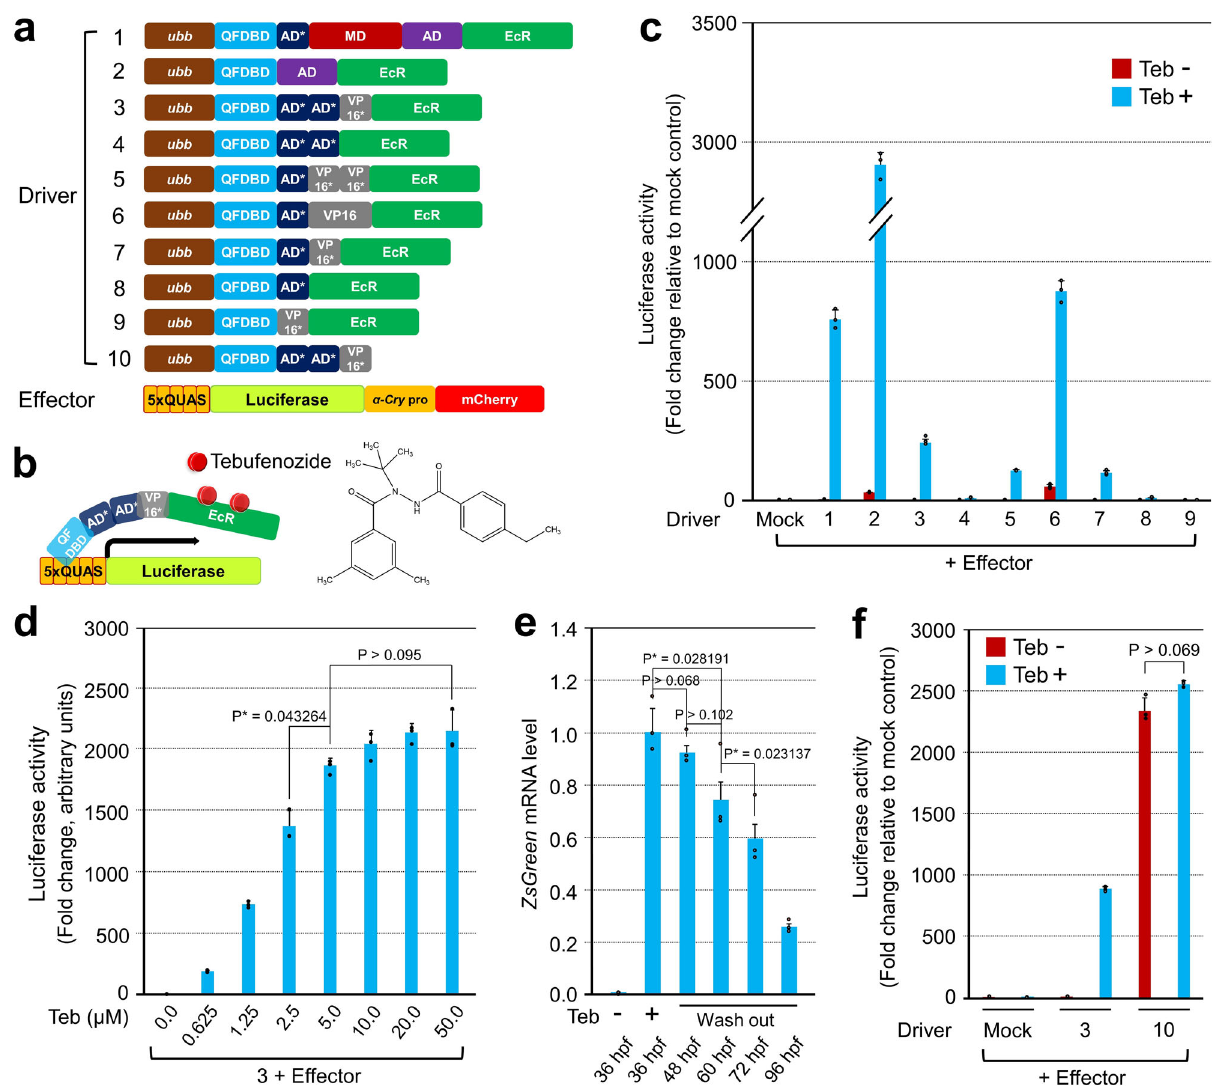
Fig. 1 Optimization of IQ-Switch for toxicity and leakiness, while retaining transgene-stimulating activity. a Alignment of driver and effector constructs tested for the optimization of IQ-Switch. b Schematic drawing of an executing mechanism of IQ-Switch. The chemical structure of tebufenozide is depicted on the right. c Measurement of luciferase reporter activity after transfection of an individual driver plasmid, indicated by number, together with the same effector containing 5xQUAS elements. After 24 h, the transfected HEK293 cells were exposed to 10 µ M of Teb for another 24 h before measurement. The luciferase reporter activity responding to Teb is indicated in azure; the basal leakiness of the effector by a speci fi c inducer plasmid is visualized in reddish brown. d The combination of driver ‘ 3 ’ in ( a ) with the effector in HEK293 cells showed responsiveness in a Teb dosage-dependent manner. Error bars stand for the standard deviation. e Reversibility of IQ-Switch. The offspring of the genetic cross between Tg ( ubb : QFDBD-2xAD*-VP16*-EcR ) and Tg ( 5xQUAS:ZsGreen-P2A-lamin A Δ 37 ) were subjected to RT-qPCR. After 50 µ M of Teb was used to treat embryos at 12 hpf for 24 h, selected ZsGreen- positive embryos were cultured under the Teb-minus condition for the indicated period. Error bars stand for the standard error of the mean. f Measurement of luciferase activity in HEK293 cells after transiently transfecting the indicated combination of plasmids. The experimental conditions are identical to those in ( c ). Driver ‘ 10 ’ in ( a ) without EcR strongly stimulated the luciferase reporter activity irrespective of the presence of Teb, the difference of which was statistically non-signi fi cant. Luciferase activity was measured in triplicate or more. P -values were indicated in each fi